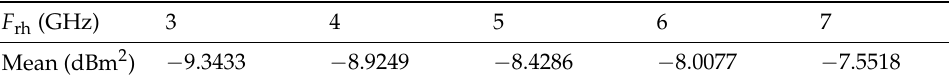
Figure 8. RCS of wing 1 under different radar wave frequencies, where A s = β = 0°. Table 4. RCS record of wing 1, where A s = β = 0 ◦